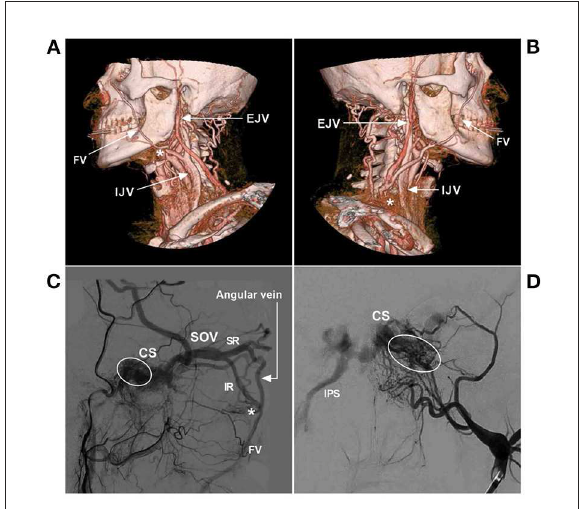
FIGURE10 Difficulty of transfemoral trans-FV-SOV to embolize CS-DAVF. (A) Lateral view CTA shows the FV jointed into the IJV. The asterisk indicates the looping of the common FV, and catheterization was difficult. (B) Lateral view CTA shows the FV jointed into the EJV. The asterisk indicates the junction of the EJV and subclavian vein; here, venous valves exist. (C) Lateral view angiography of the ECA shows the veins of the orbit region. The asterisk indicates that venous valves exist at the inferior root of the SOV, and the circle indicates the fistula point of the CS-DAVF. (D) Anterior–posterior view angiography of the ECA shows the fistula point (circle) of the CS-DAVF. CS, cavernous sinus; DAVF, dural arteriovenous fistula; ECA, external carotid artery; EJV, external jugular vein; FV, facial vein; IJV, internal jugular vein; IPS, inferior petrous sinus; IR, inferior root; SOV, superior ophthalmic vein; SR, superior